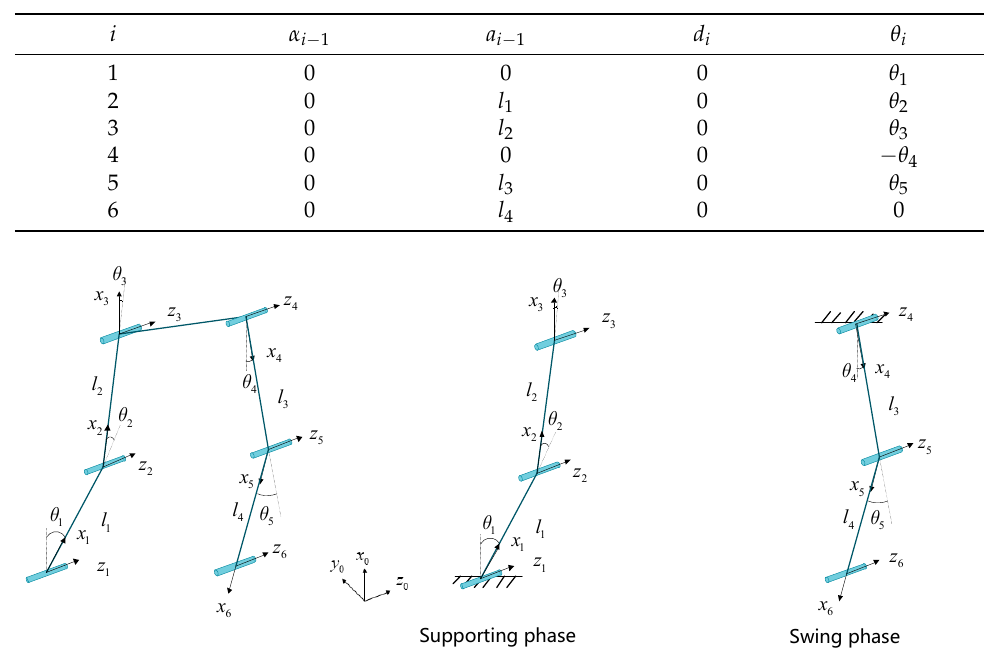
q is the motion angle for ankle joint. q and q are motion angles Figure 14. Five-link model. Figure 14. Five-link model. θ 1 is the motion angle for ankle joint. θ 2 and θ 5 are motion angles for 1 2 5 q and q are motion angles for hip joints. l and l are the distance between knee joints. θ 3 and θ 4 are motion angles for hip joints. l 1 and l 4 are the distance between ankle joints for knee joints. 3 4 1 4 and knee joints. l 2 and l 5 are the distance between knee joints and hip joints. D-H parameters among l and l are the distance between knee joints and hip joints. D-H ankle joints and knee joints. 2 5 variables are shown in Table parameters among variables are shown in Table 2. Table 2. D-H parameters.